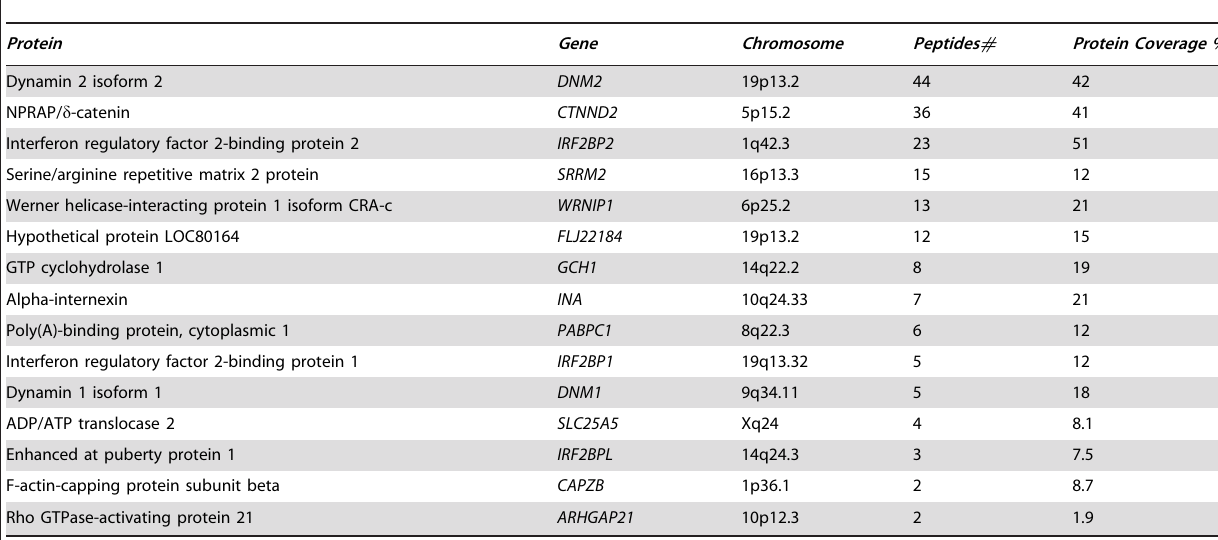
Table 1. A list of proteins identified by mass spectrometry as NPRAP-binding partners.